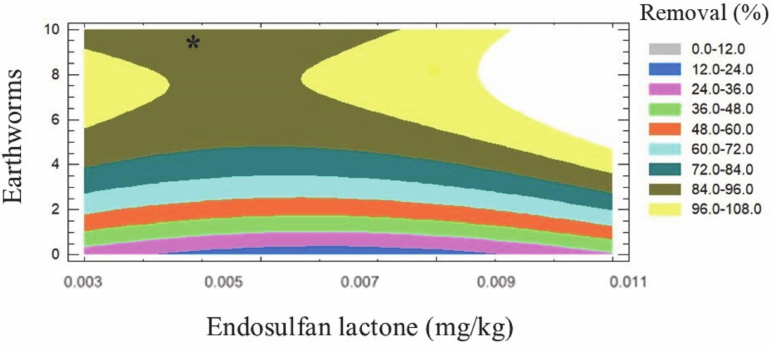
Figure 8. Representation of the response surface by contour plot for endosulfan lactone removal on day 14 in sterile solid